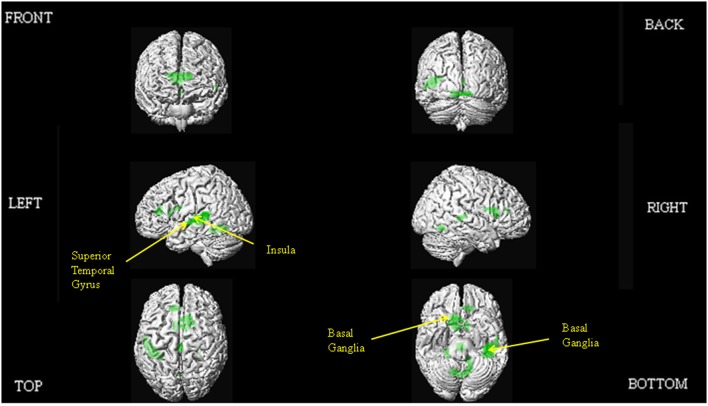
Depiction of the brain regions activated when expressing neutrality through prosody (relative to jaw movement), displayed on a rendered brain derived from the Montreal Neurological Institute Ch2bet.nii image supplied with the MRIcroN software (http://www.mccauslandcenter.sc.edu/mricro/mricron/index.html). Regions of activation on the external surface of the cortex appear brighter and more intense, whereas regions deeper in the cortex are displayed in less intense, more transparent shades. Images are thresholded at PFWE <0.05 with a 10 voxel spatial contiguity threshold.